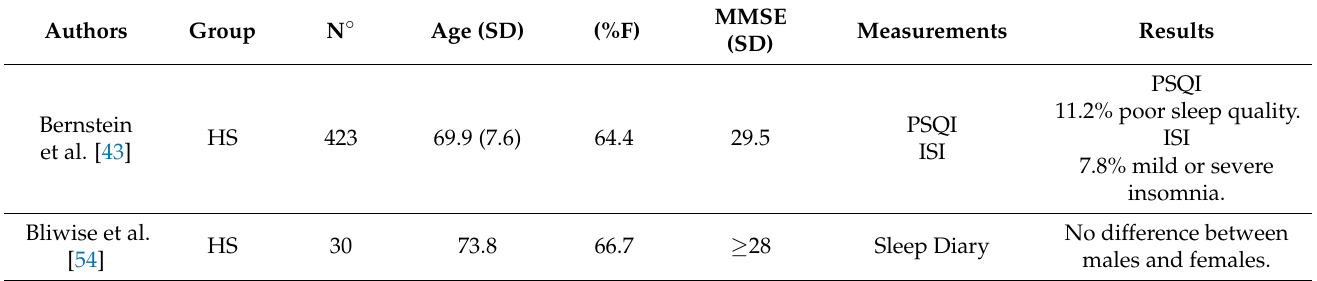
Table 2. Sleep in older age. Summary of all the studies that use subjective